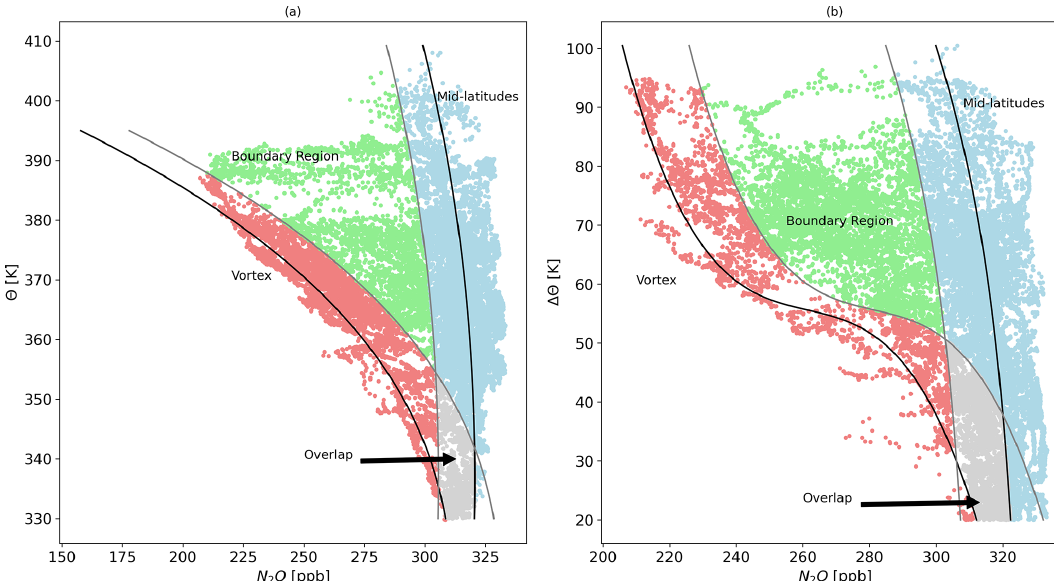
Figure 2. Midlatitude and vortex profiles (black) of N 2 O versus (a) potential temperature ( (cid:50) ) and (b) potential temperature difference ( (cid:49)(cid:50) ) from the local PV tropopause. The vortex cutoff criterion (see main text for details) of 20ppb is illustrated by the grey profile on the right side of the vortex profile. Midlatitude variability of 15ppb is illustrated with the grey profile on the left side of the midlatitude profile. In between these is the vortex boundary region. The overlap region is declared for the area where the vortex cutoff and midlatitude variability cross. Additionally, N 2 O measurements classified to the respective region are displayed. Vortex measurements are in red, vortex boundary region measurements are in green, midlatitude measurements are in blue, and overlapping measurements are in